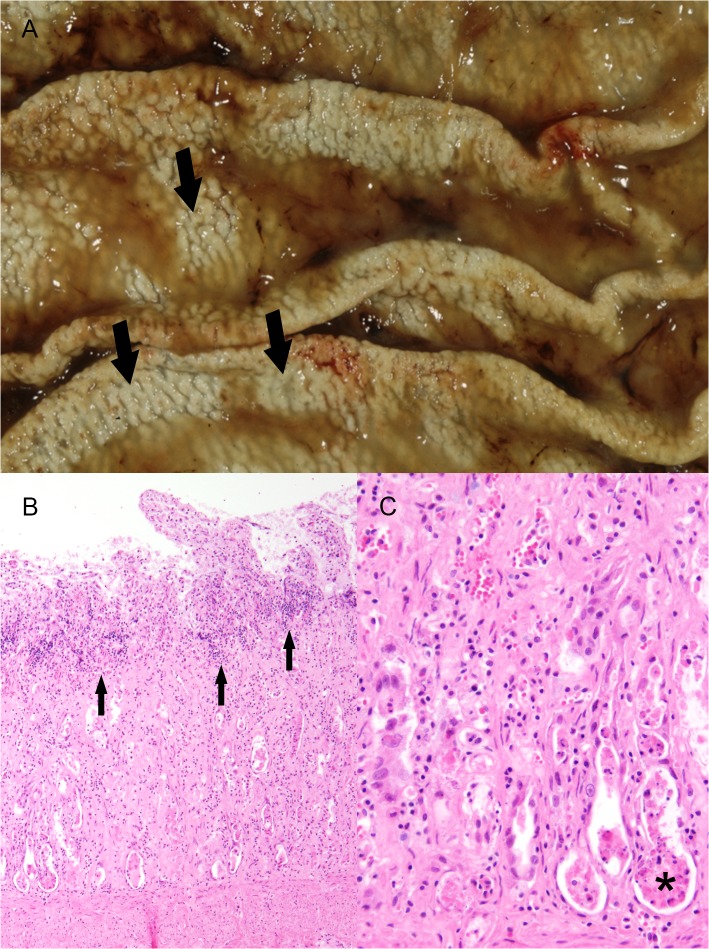
Gastrointestinal lesions in wild felids.A) Stomach, tiger, 1 year, male (animal no. 36). Severe diffuse mineralization of the gastric mucosa consisting of white, granular, crunchy material (arrows). B) Jejunum, tiger, 3 years, female (animal no. 37). Villus fusion, shortening and loss of epithelial cells with cellular debris and multifocal, moderate, lympho-plasma-histiocytic inflammation (arrows). H&E-staining. C) Jejunum, tiger, 3 years, female (animal no. 37). Higher magnification of Fig 2B, jejunum with crypt dilatation and accumulation of cellular debris in the crypts (asterisk). H&E-staining.